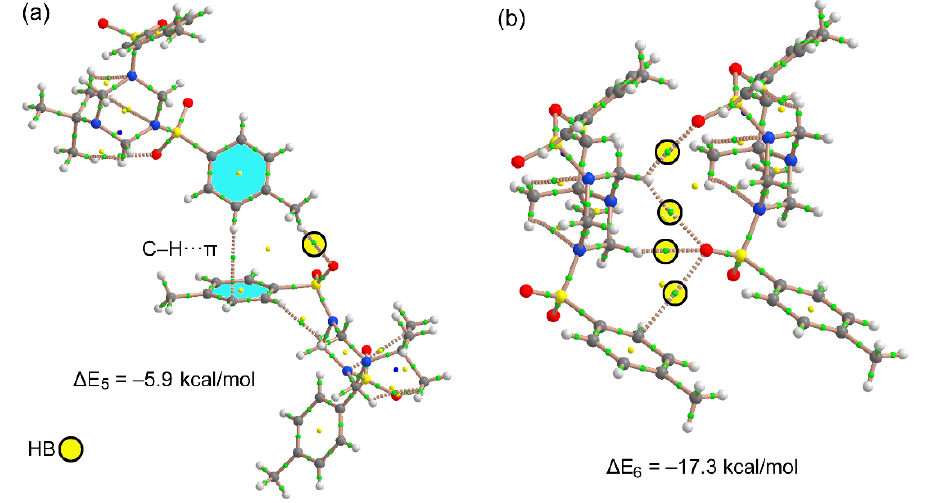
Figure 11. ( a , b ) Distribution of bond, ring and cage critical points (green, yellow and blue spheres, respectively) and bond paths in two dimers of complex 3 . The C–H ··· O bonds are highlighted.